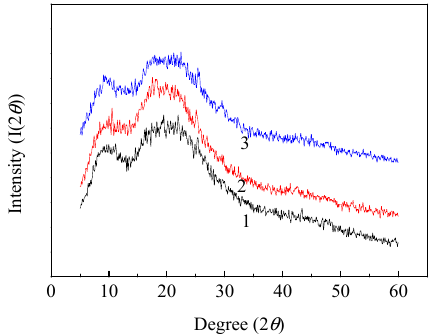
Figure 9. XRD patterns of diacetate fiber:(1) Untreated diacetate fiber; (2) Diacetate fiber treated by SCF-CO 2 at 80 °C, 20 MPa, 90 min; (3) Impregnation of diacetate fiber with resveratrol in SCF-CO 2 at 80 °C, 20 MPa, 90 min.